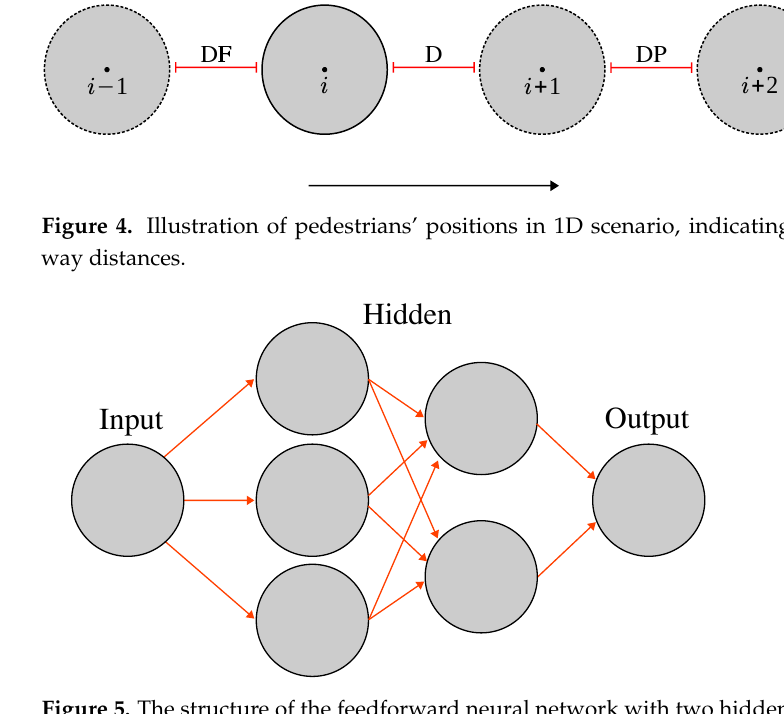
Figure 5. The structure of the feedforward neural network with two hidden layers (3,